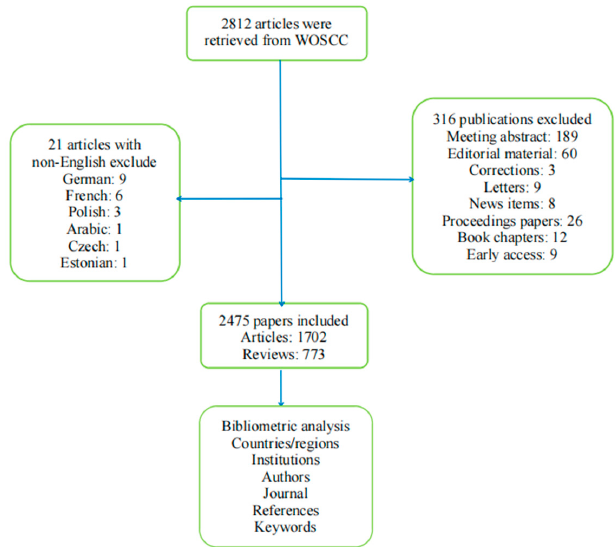
Figure 1. Schematic diagram of the search process.